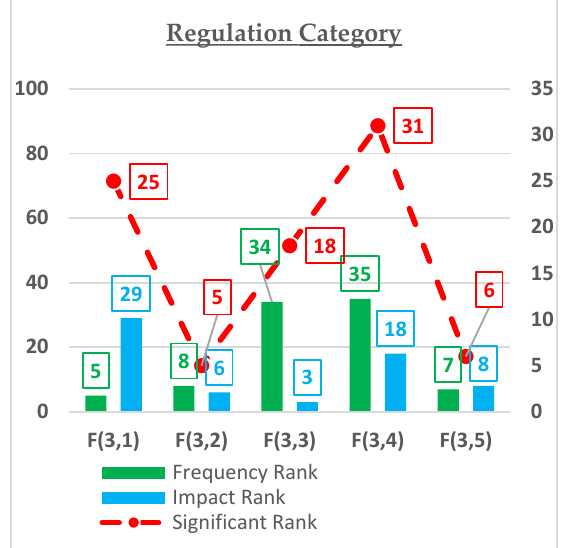
Figure 9. Significant risks in the regulation category.